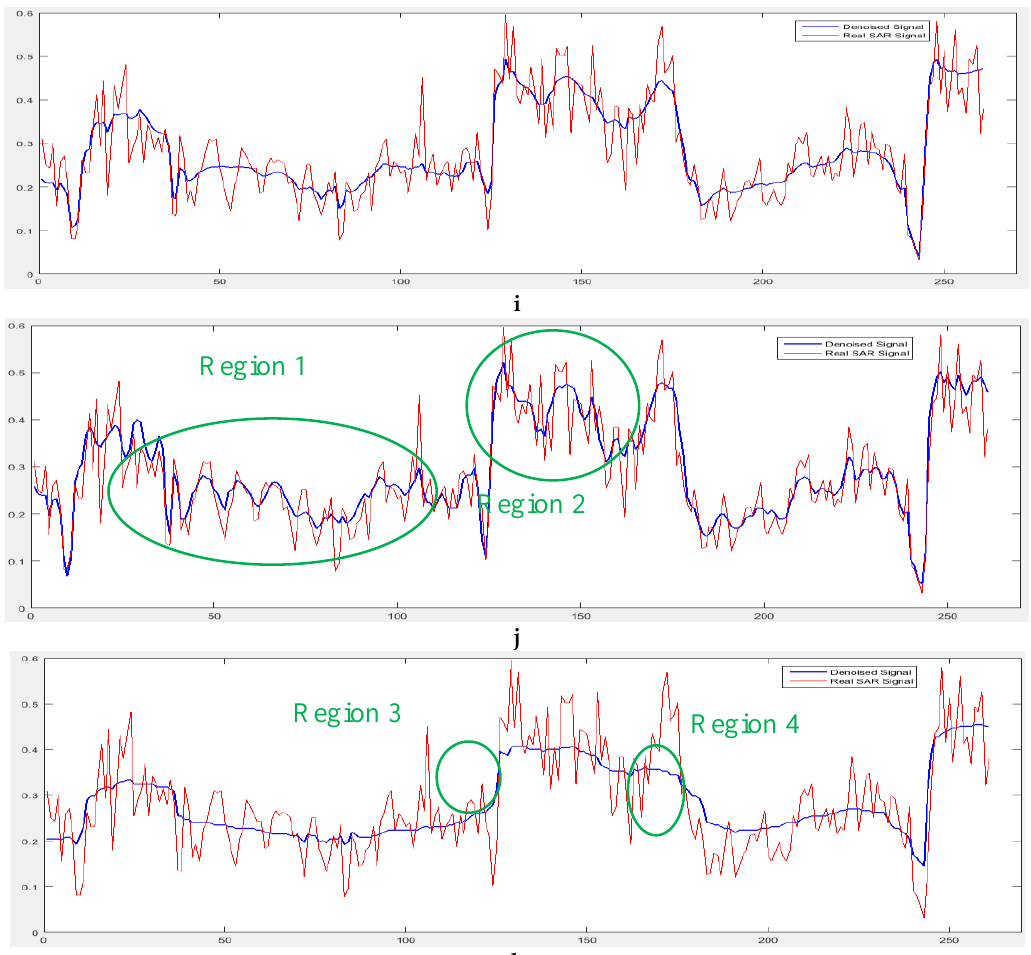
Figure 12. ( a ) Real SAR image 2, ( b ) denoised SAR image by DPAD filter, ( c ) denoised SAR image by SAR-BM3D filter, ( d ) denoised SAR image by fast bilateral filter, ( e ) denoised SAR image by bilateral filter, ( f ) denoised SAR image by WLS filter, ( g ) denoised SAR image by the proposed method, ( h ) signal on proposed denoised image, ( i ) comparison of proposed denoised signal and degraded signal, ( j ) Comparison of SAR-BM3D denoised signal and degraded signal, ( k ) comparison of WLS filter denoised signal and degraded signal.